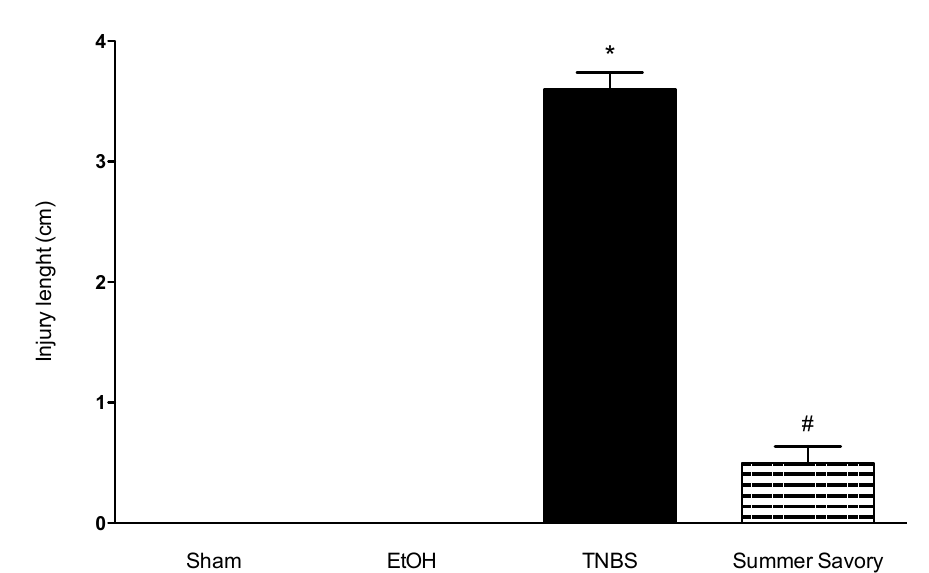
Figure 6. Effect of Summer Savory extract administration on the colon injury extent (cm). * p < 0.001 vs. Sham; # p < 0.001 vs. TNBS. Sham Group ( n = 6); EtOH Group ( n = 6); TNBS + EtOH Group ( n = 10); TNBS + Summer Savory Group ( n = 10).